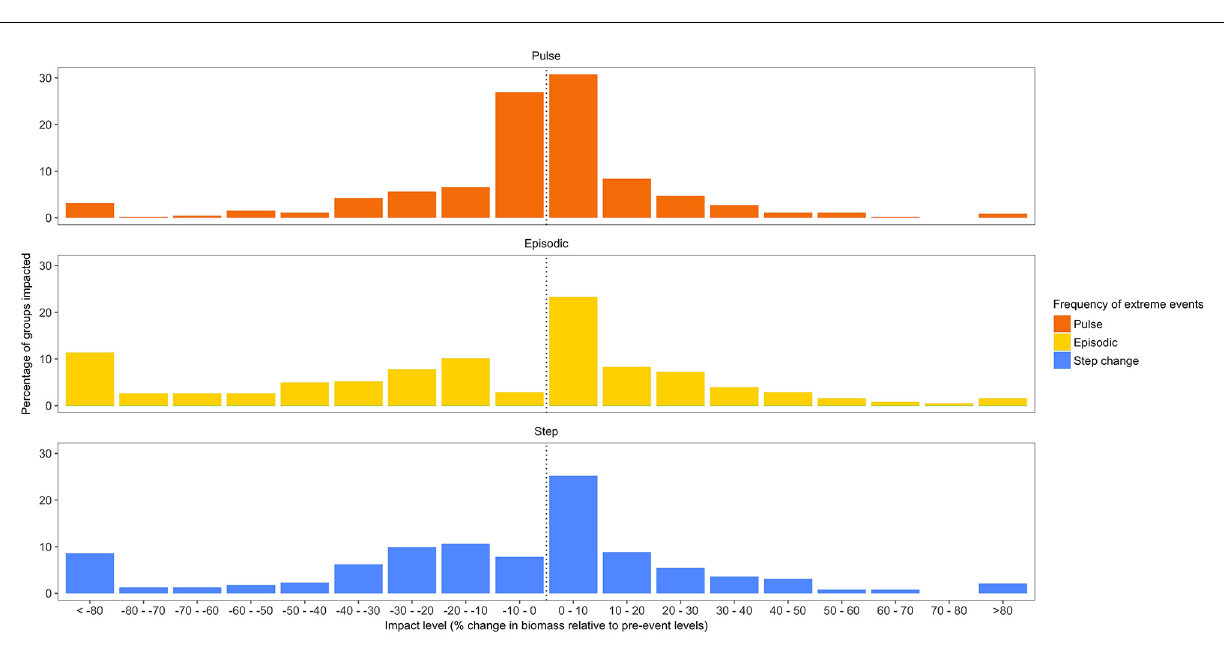
Frontiers in Marine Science |